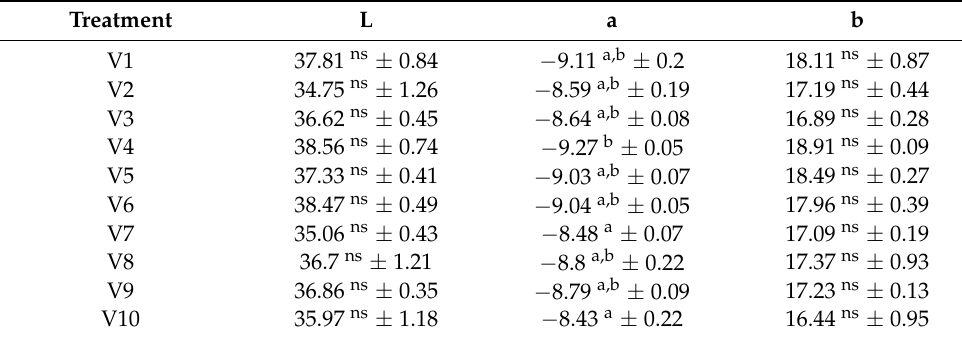
The values represent the mean ± standard error. The lowercase letters represent a statistically significant difference (Tukey Test, p < 0.05), ns: not significant. L: lightness—darkness, a: redness—greenness, and b: yellowness—blueness.